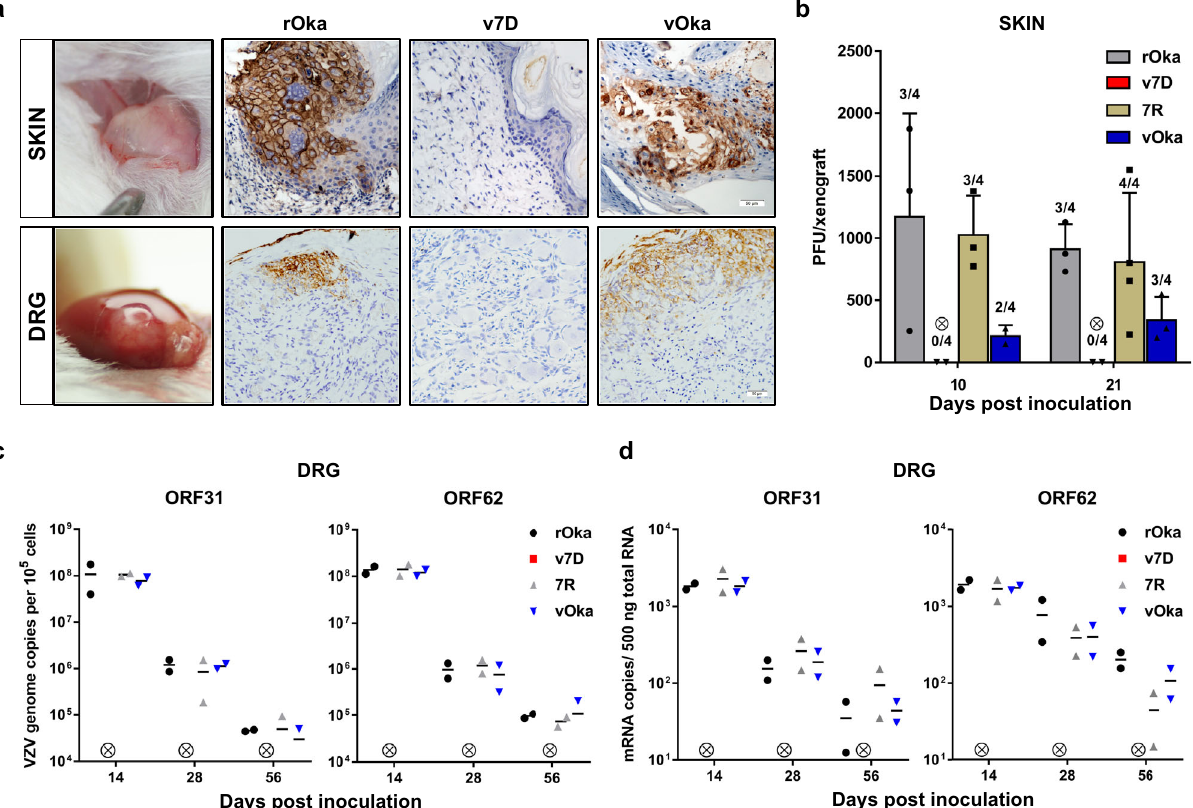
Fig. 3 v7D is severely attenuated in human skin and neuronal tissues in vivo. Human fetal skin and DRG tissues engrafted in the SCID-hu mice were mock-infected or infected with cell-free rOka, v7D, 7R, and vOka, respectively. The inoculum doses for skin and DRG were 1 × 10 4 and 1 × 10 3 PFU per xenograft, respectively. a Anti-gE IHC analysis of infected skin and DRG xenografts. Images of infected skin and neuronal cells were captured at 21 and 14 dpi, respectively. Scale bar, 50 μ m. b Viral titers in skin xenografts were determined by plaque assay in MRC-5 cells at 10 and 21 dpi. The number of xenografts from which infectious virus was recovered per number of inoculated xenografts is shown above each bar. Mean titers per group were calculated based on data from xenografts that yielded viable virus. The results are represented as averages ± the SD. c Mean VZV genome copy numbers in infected DRG xenografts ( n = 2 per group) using probes for ORF31 and ORF62 at 14, 28, and 56 dpi. Adjustment was made for ORF62 copy numbers to re fl ect that each VZV genome contains two copies of ORF62. d mRNA transcripts of VZV ORF31 and ORF62 in infected DRG xenografts ( n = 2 per group) at 14, 28, and 56 dpi. A circle containing a cross indicates that none of the animals in the v7D group had detectable viral titers, VZV DNA or RNA. The experiments were repeated twice, and representative results are shown. Source data are provided as a Source Data fi